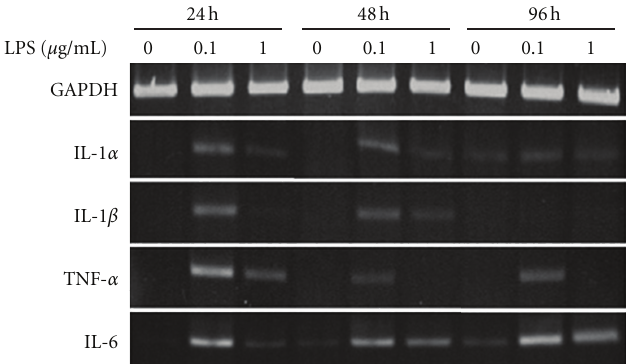
Figure 7: Expression of pro-inflammatory cytokine genes in human gingival fibroblasts. Gene expression for IL-1 α , IL-1 β , TNF- α , IL-6, and GAPDH genes in hGF cultures with and without LPS stimulation. LPS concentrations were 0 μ g/mL, 0.1 μ g/mL or 1 μ g/mL. RNA was isolated at 24, 48, and 96 hours. RT-PCR was carried out at 30 cycles for GAPDH, 35 cycles for IL-1 α , IL-1 β , and TNF- α , and 25 cycles for IL-6.